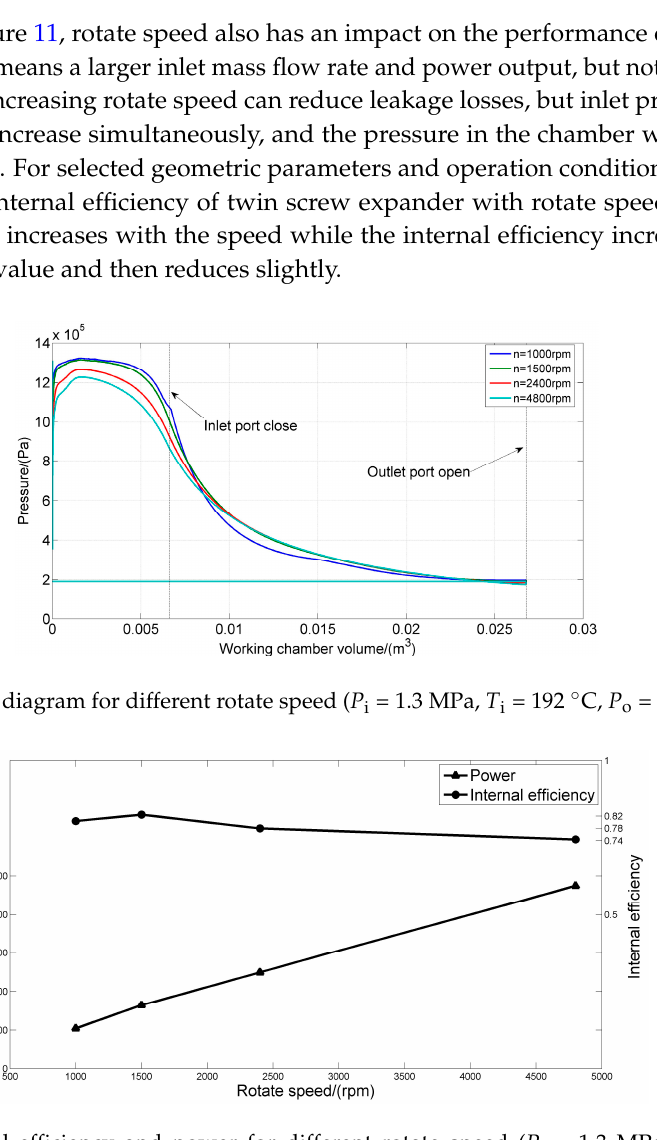
◦ C, i = 1.3 MPa, T i = 192